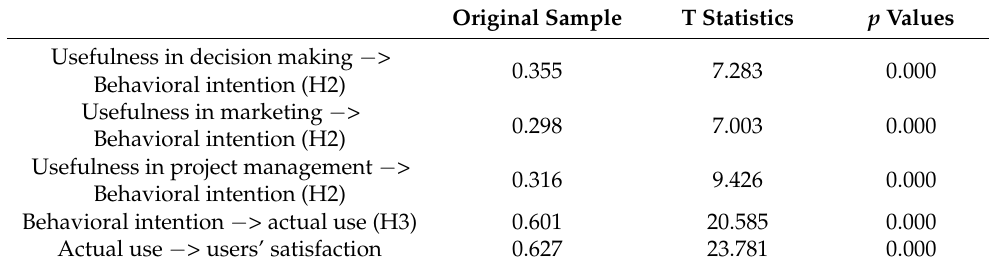
Table 5. Path coefficients.